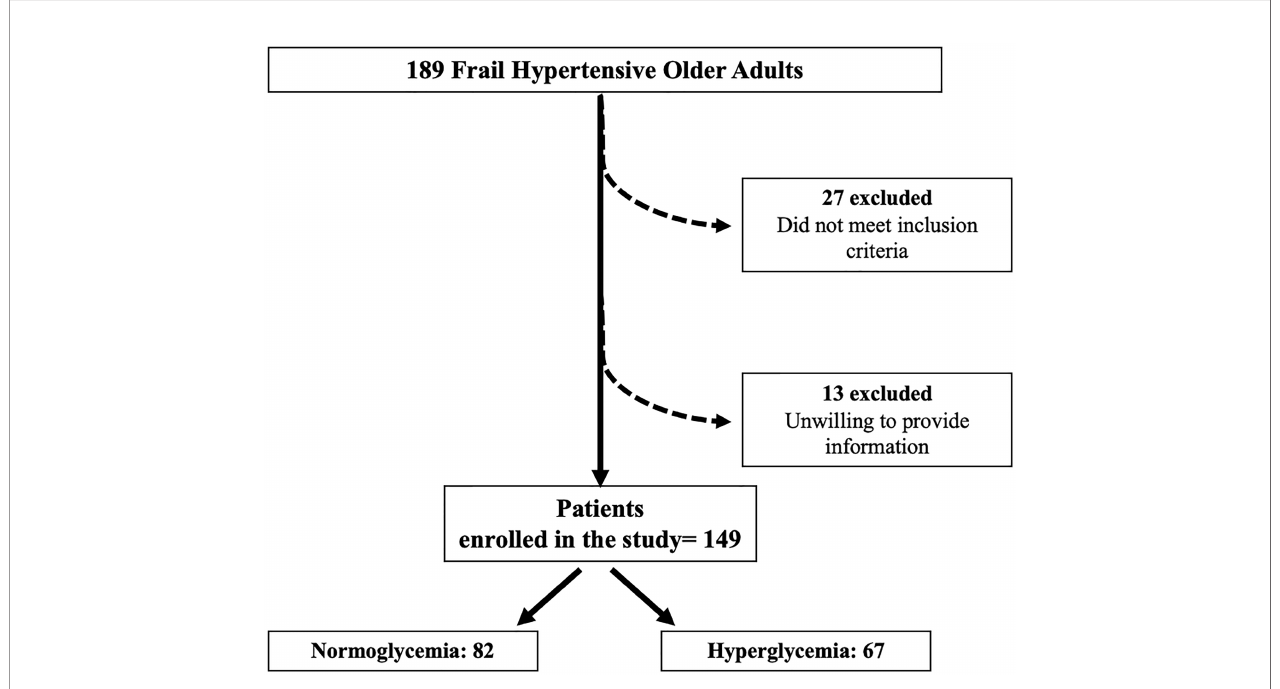
FIGURE 1 | Study fl ow